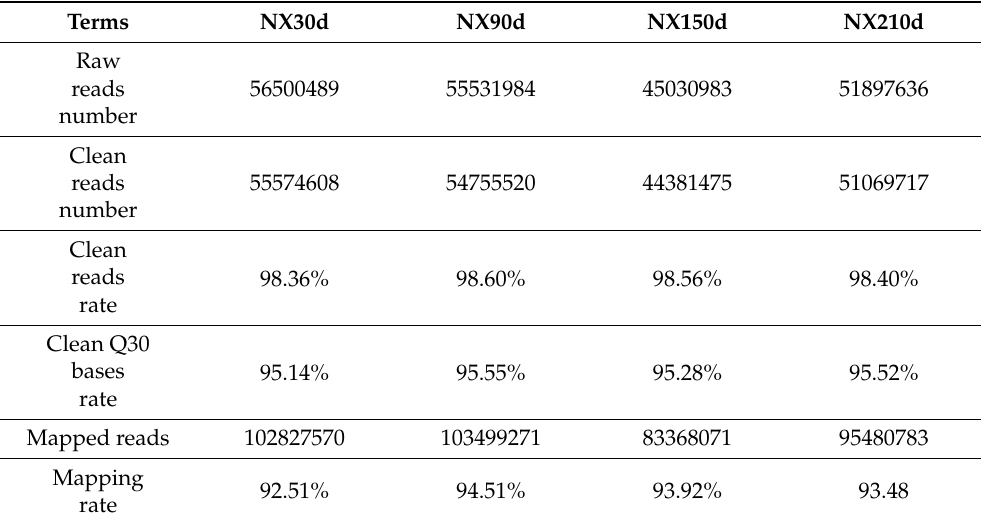
Table 1. Sequencing basic data of four different developmental stages of Ningxiang pig